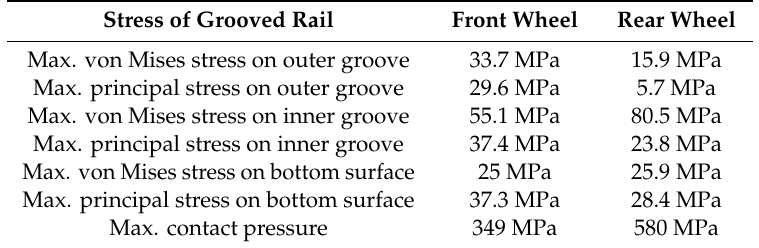
Table 4. Von Mises stress, maximum principal stress, and maximum contact pressure in the rail.